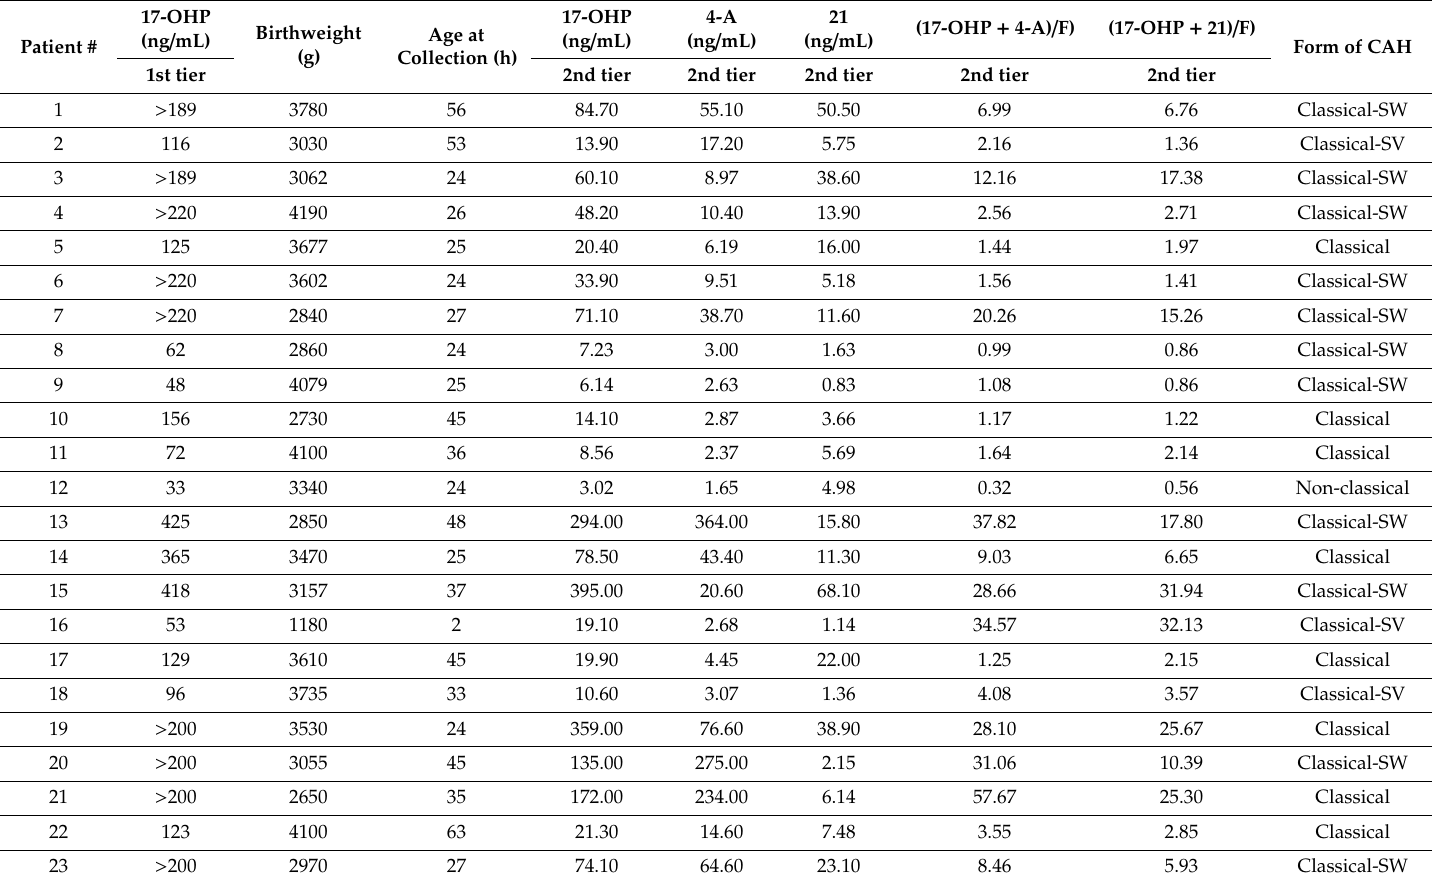
Table 4. Summary of confirmed congenital adrenal hyperplasia (CAH) cases identified by newborn screening. Table 4 provides the concentration of 17OHP measured by the first-tier assay and the concentrations of 17OHP, 4-A, 21, and ratios measured by the second-tier assay within confirmed cases. The non-shaded cases were evaluated as part of the second-tier assay validation. The shaded cases were identified during the one-year prospective study. The form of CAH confirmed within each patient is provided. For some patients (labeled as only classical), the endocrinologist did not distinguish between salt wasting and simple virilizing forms of CAH. SW = salt wasting, SV = simple